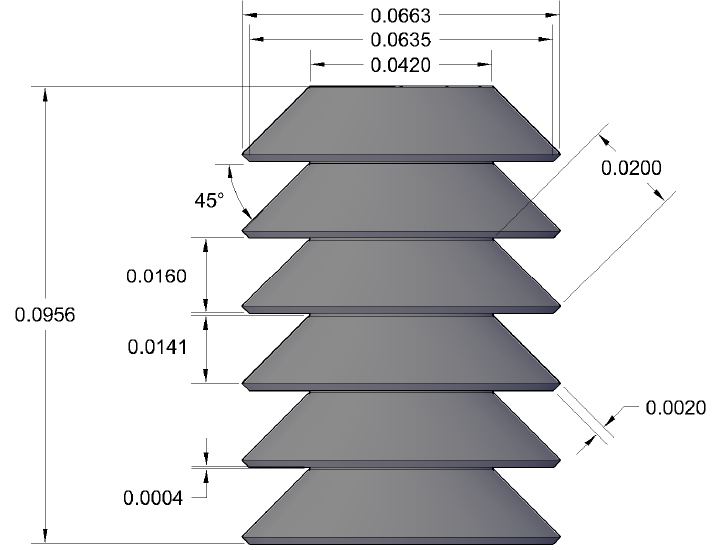
Figure 3. Schematic representation of the finned cylinder with dimensional characteristics in